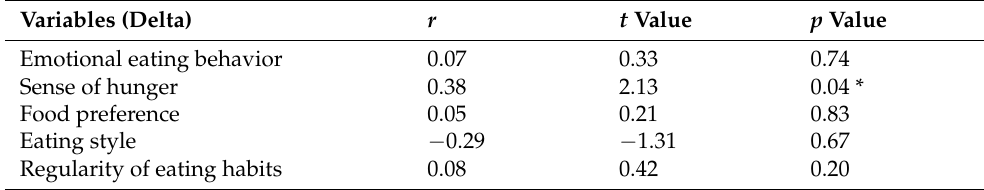
Table 4. Multiple linear regression models with delta-HbA1c as the dependent